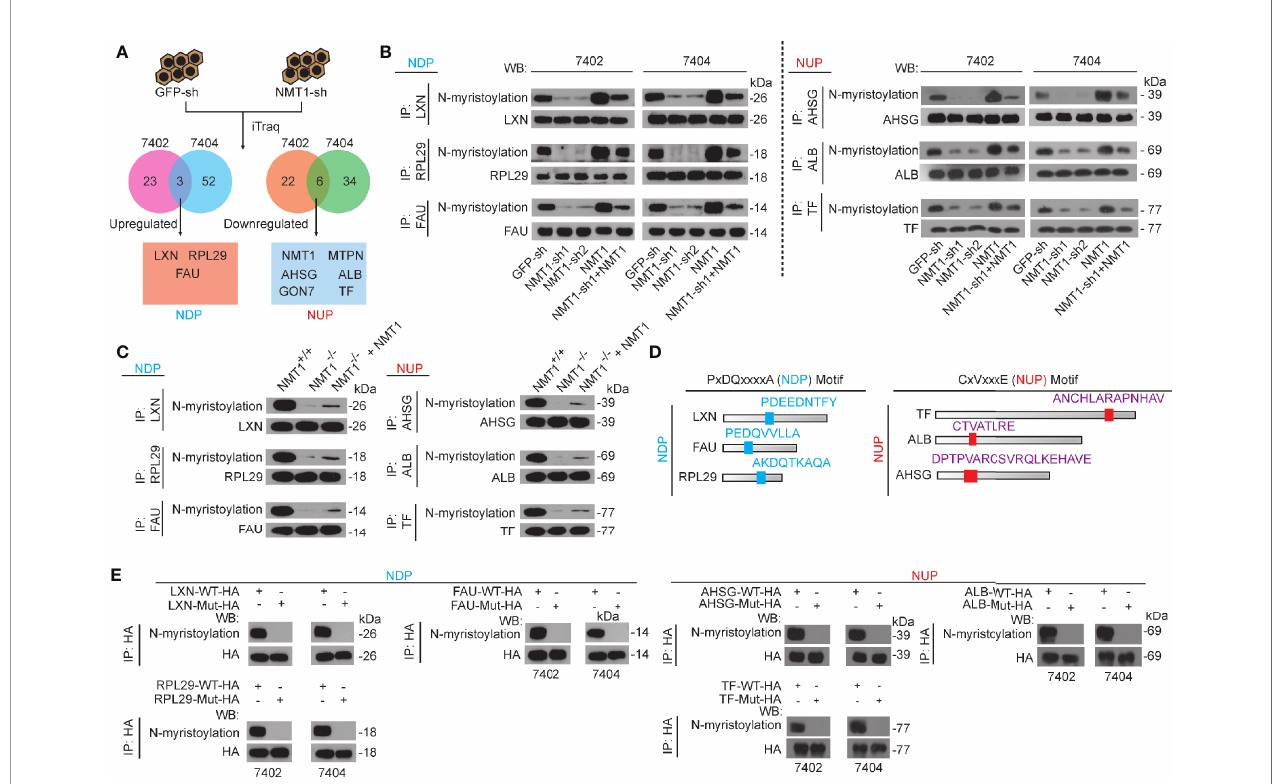
FIGURE 2 | Two categories of NMT1 targets could all be N-myristoylated. (A) NDP and NUP were identi fi ed up-regulated or down-regulated by NMT1 knockdown in both Bel-7402 and Bel-7404 cells, as revealed by iTraq (two biological replicates). (B) N-myristoylation of both NDP and NUP could be positively regulated by NMT1. NDP and NUP were immuno-precipitated by corresponding antibodies and visualized by CuAAC and WB in both Bel-7402 and Bel-7404 cells. (C) N- myristoylation of NDP and NUP were positively controlled by NMT1 in mouse liver. NDP and NUP were immuno-precipitated from liver of mice, as indicated, and N- myristoylation of NDP and NUP were measured by CuAAC and WB. (D) Motif discovery of common motifs in NDP and NUP. (E) NDP and NUP motifs were critical for N-myristoylation of NDP and NUP. Exogenous NDP/NUP with (WT) or without functional NDP/NUP motifs (Mut) were expressed in Bel-7402 and Bel-7404 cells. N-myristoylation of exogenous NDP/NUP were immuno-precipitated by anti-HA antibodies and measured by CuAAC and WB. Images of WB are representative ones of 3 independent